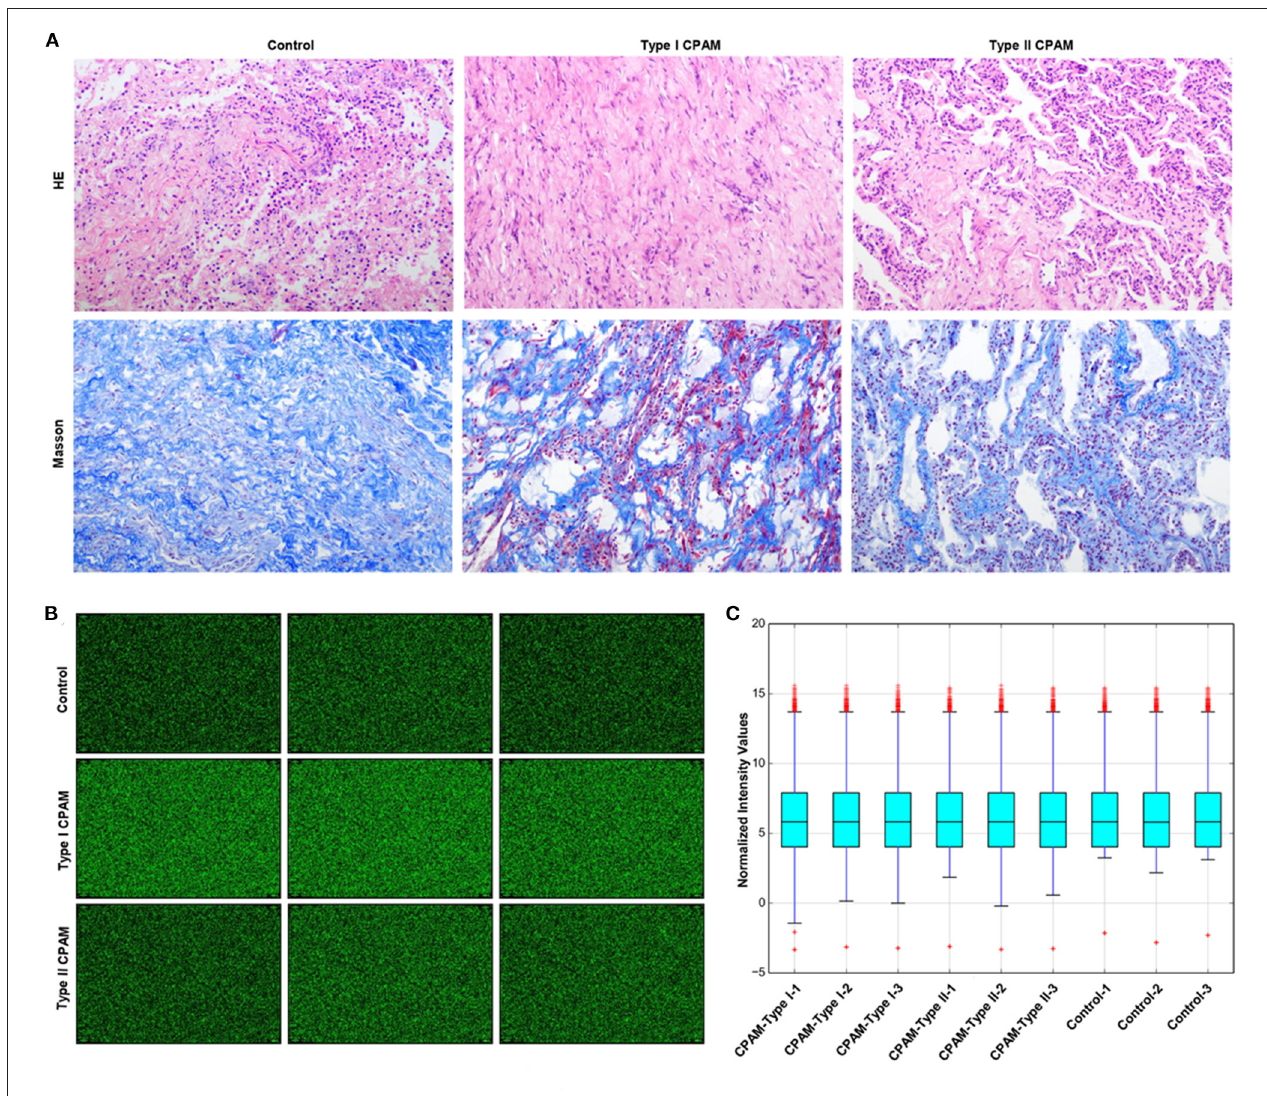
FIGURE 1 | miRNA chip information of type I and type II CPAM detected using the Agilent 8 × 60 K miRNA-array platform. (A) HE and Masson staining analysis of lung tissues from type I and type II CPAM, (B) miRNA chip images scanned by Agilent Feature Extraction software (v11.0.1.1), and (C) Normalized intensity values of miRNA chip signals in type I, type II CPAM, and control groups.